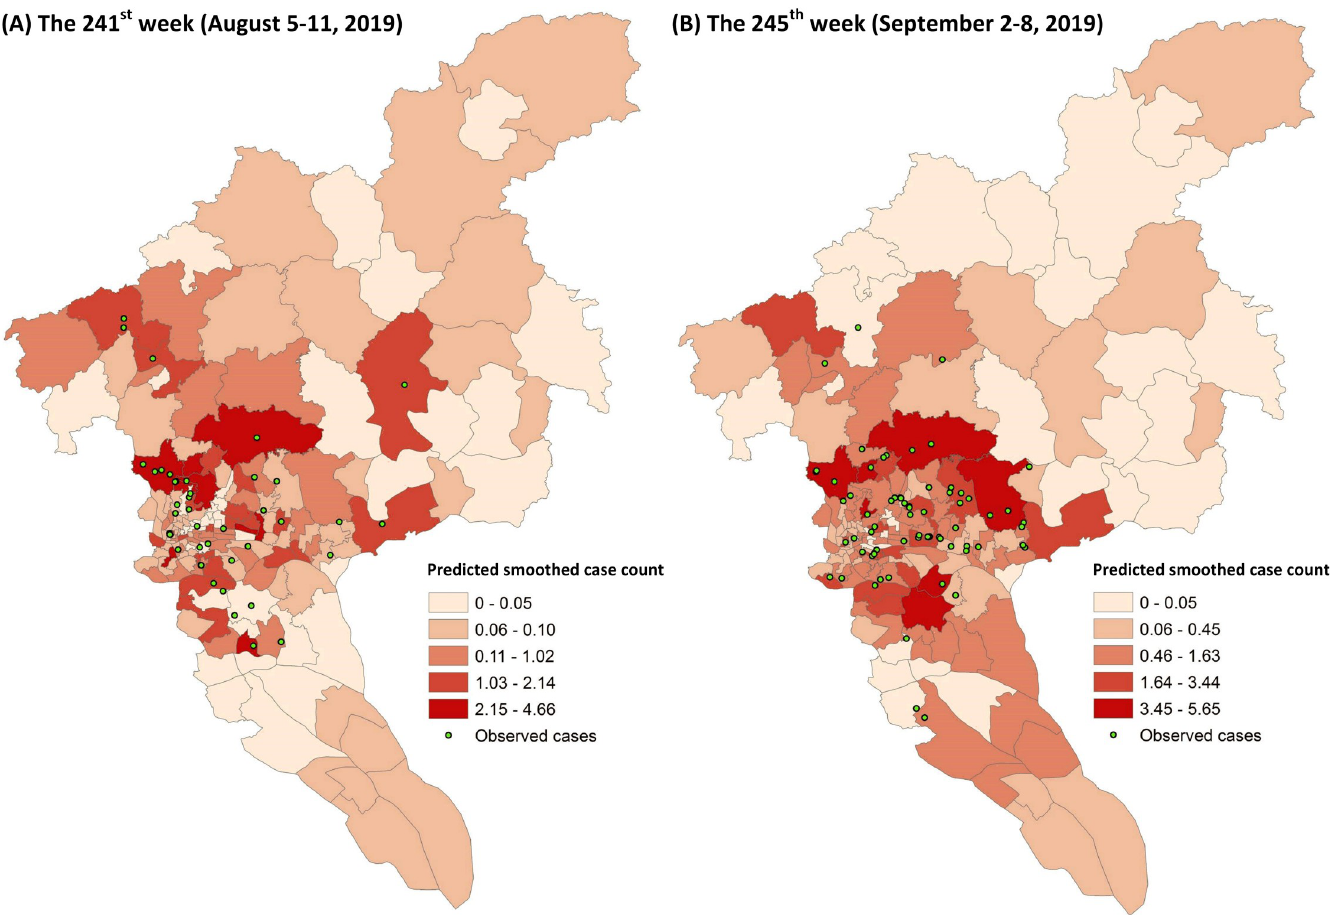
Fig 9. Predicted smoothed case counts of all townships during two different weeks. The smoothed case counts were predicted by the 1-week ahead SVM-based model using both common features and interaction